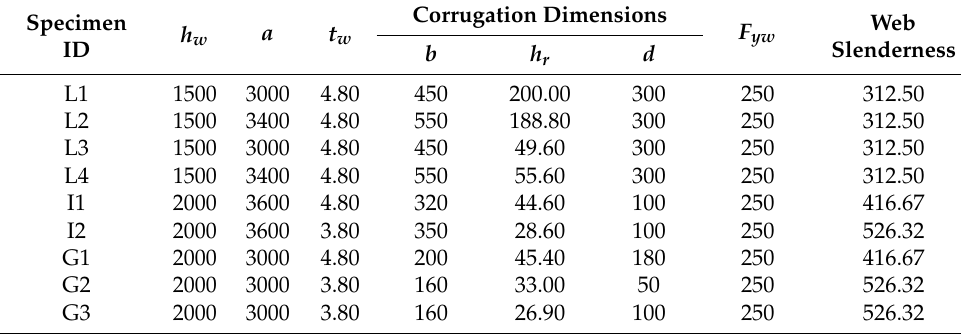
Table A6. Data of specimens tested by Lee et al. [28].